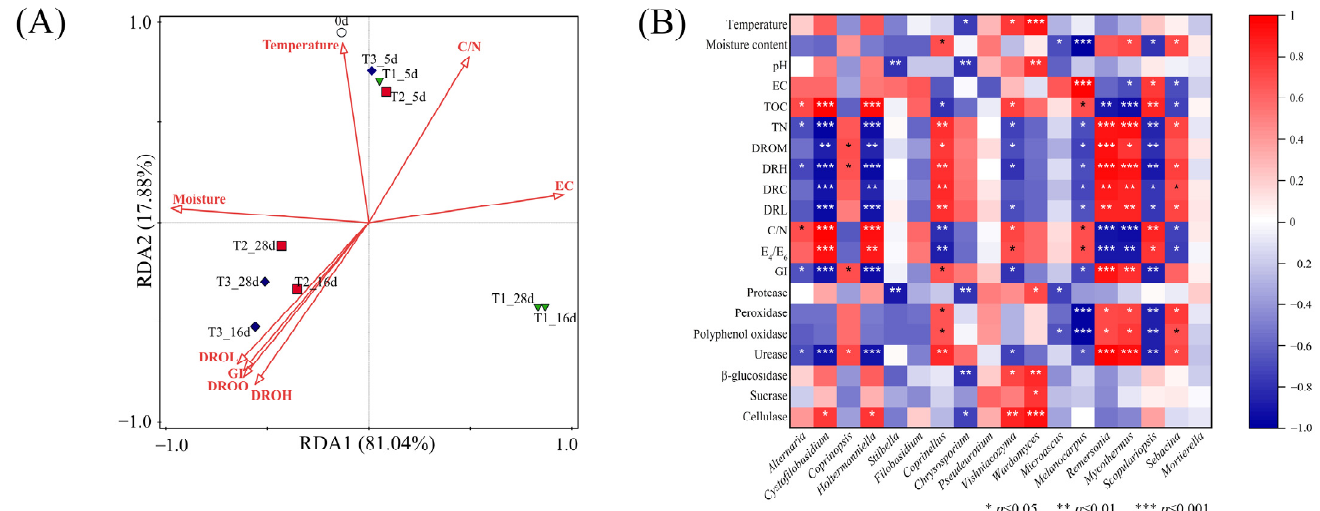
Figure 6. Redundancy analysis (RDA) ( A ) and correlation heat map ( B ) between fungus and physicochemical indicators. DROM: Degradation rate of organic matter; DRH: Degradation rate of hemicellulose; DRC: Degradation rate of cellulose; and DRL: Degradation rate of lignin.